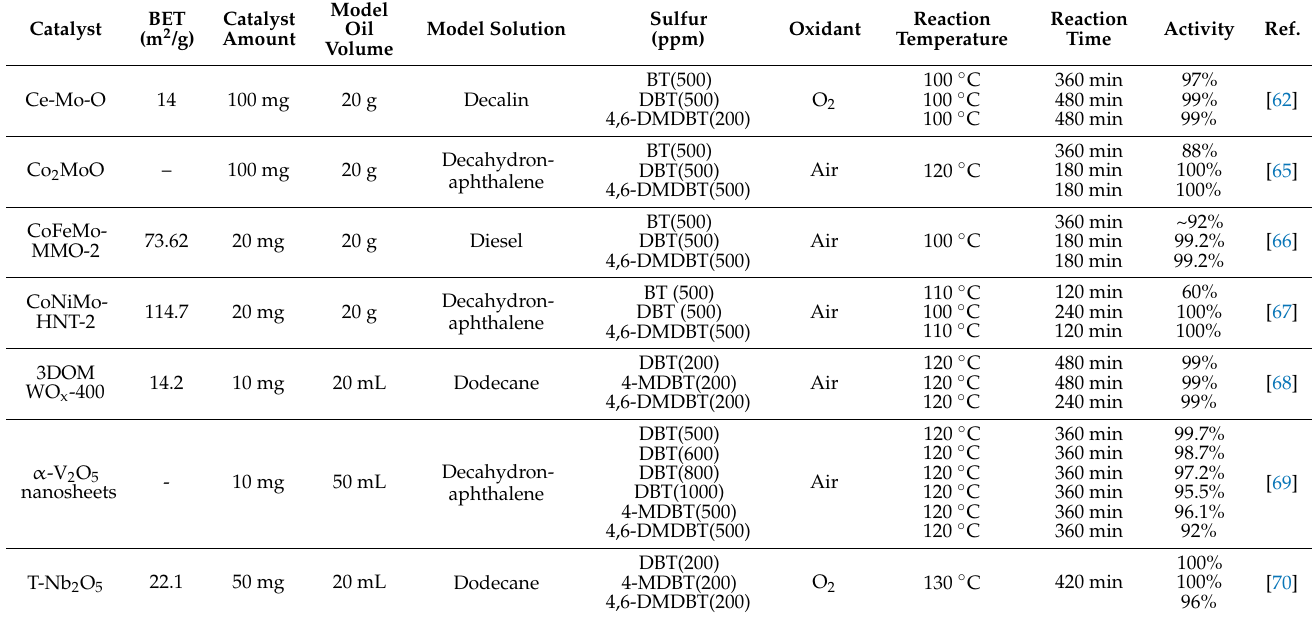
Table 2. Comparison on the catalytic performance of porous metal oxides as AODS